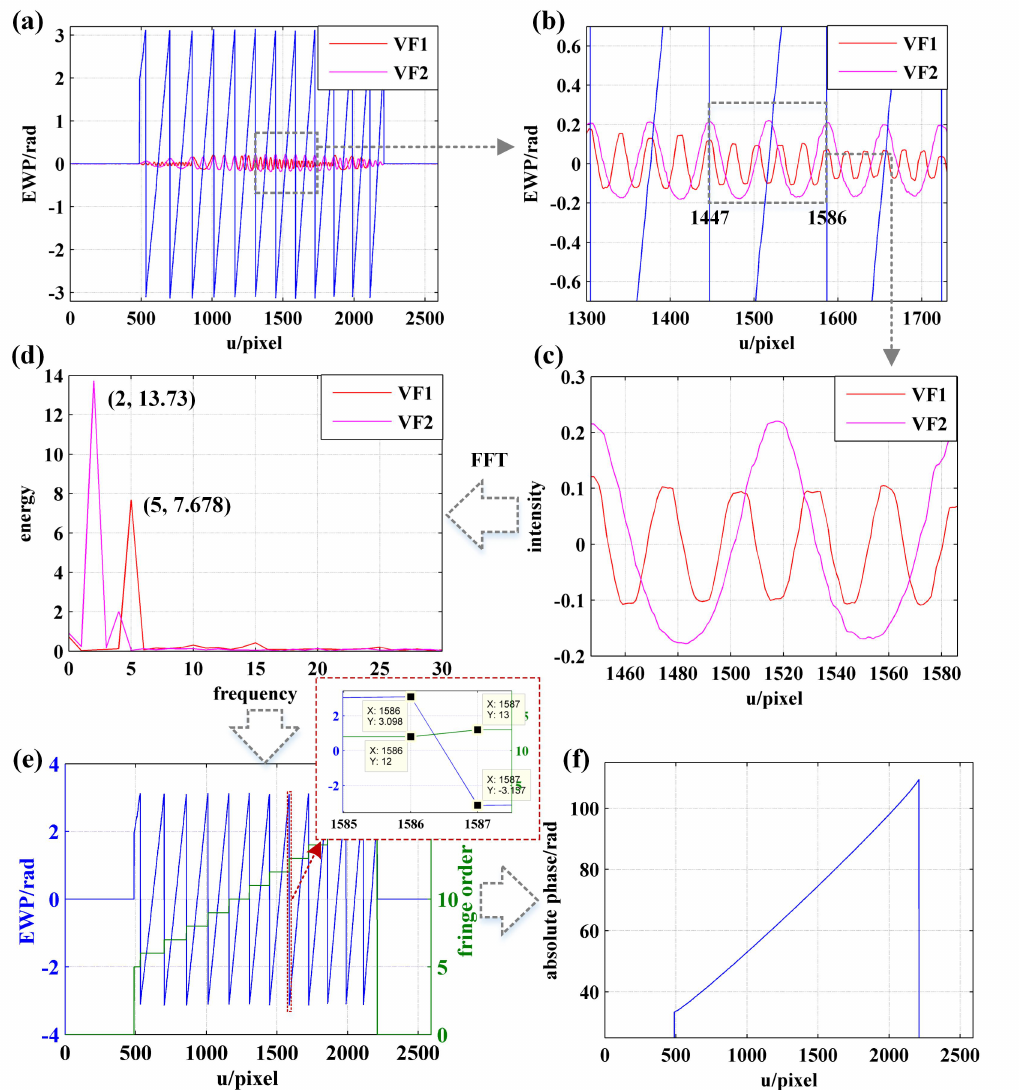
Figure 12. Phase unwrapping result of row 1000 obtained using the proposed method: ( a ) EWP and coded fringes; ( b ) EWP and coded fringes with pixel interval of [1300, 1730]; ( c ) coded fringes with pixel interval of [1447, 1586]; ( d ) FFT spectrum of (c); ( e ) EWP and fringe order; ( f ) absolute